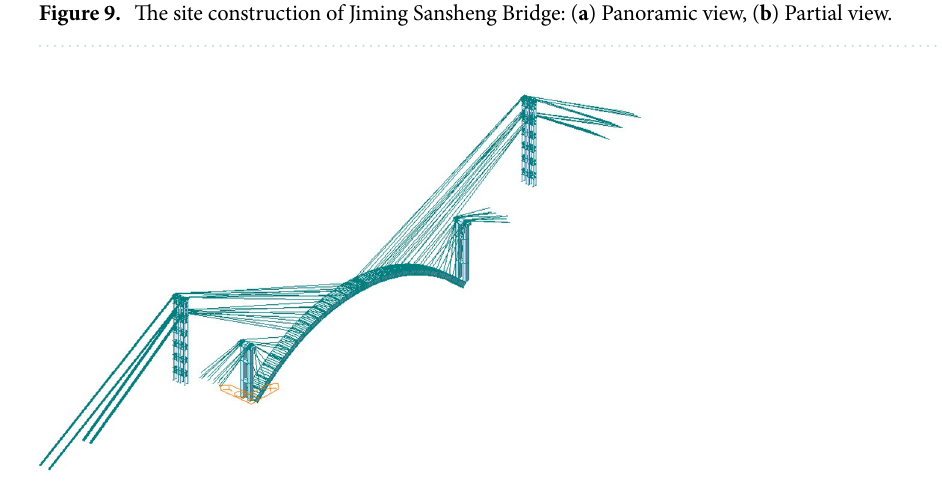
Figure 9. The site construction of Jiming Sansheng Bridge: ( a ) Panoramic view, ( b ) Partial view.